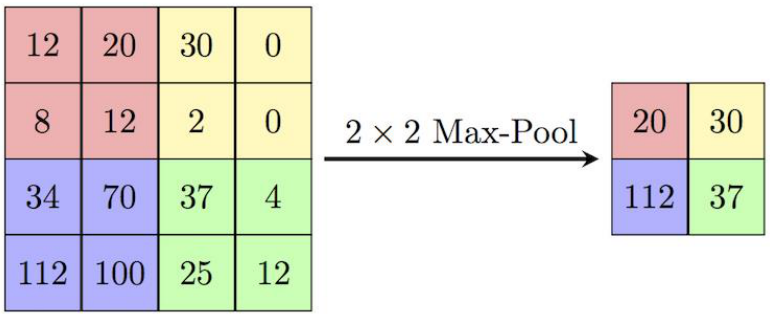
Figure 4. The downsample computed by the max pooling.